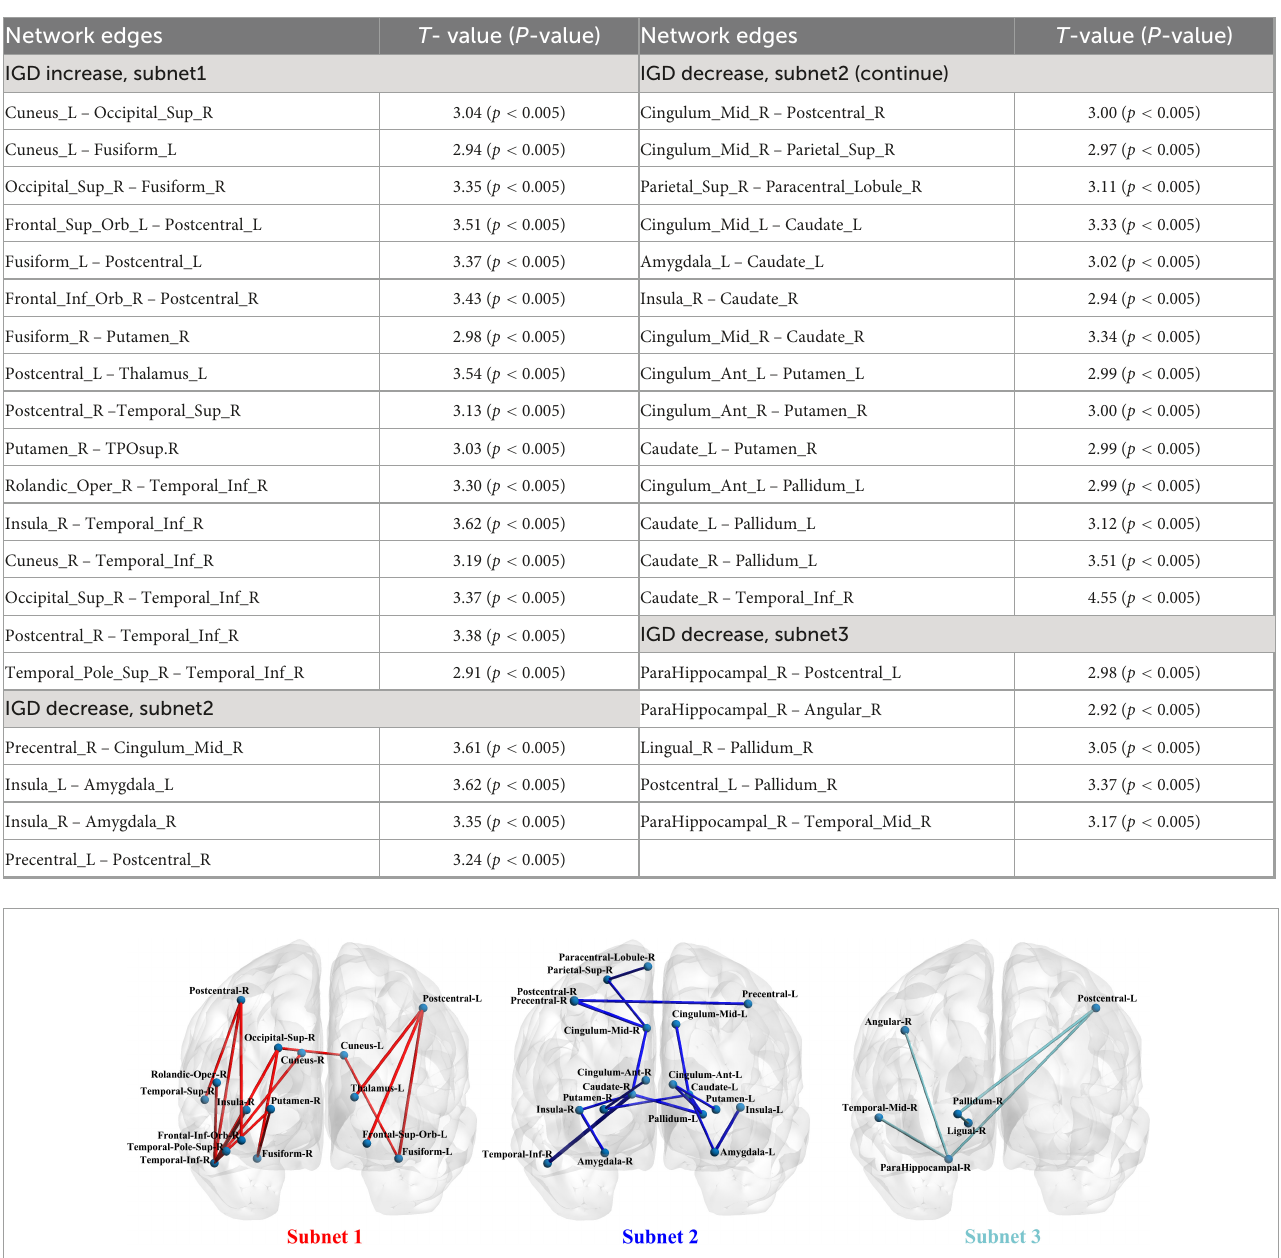
FIGURE2 The three subnetwork results from the network-based statistics (NBS) analysis in a coronal view.